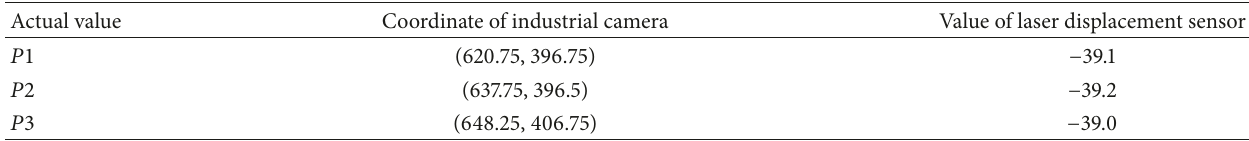
Table 9: Values after changing coordinate system.